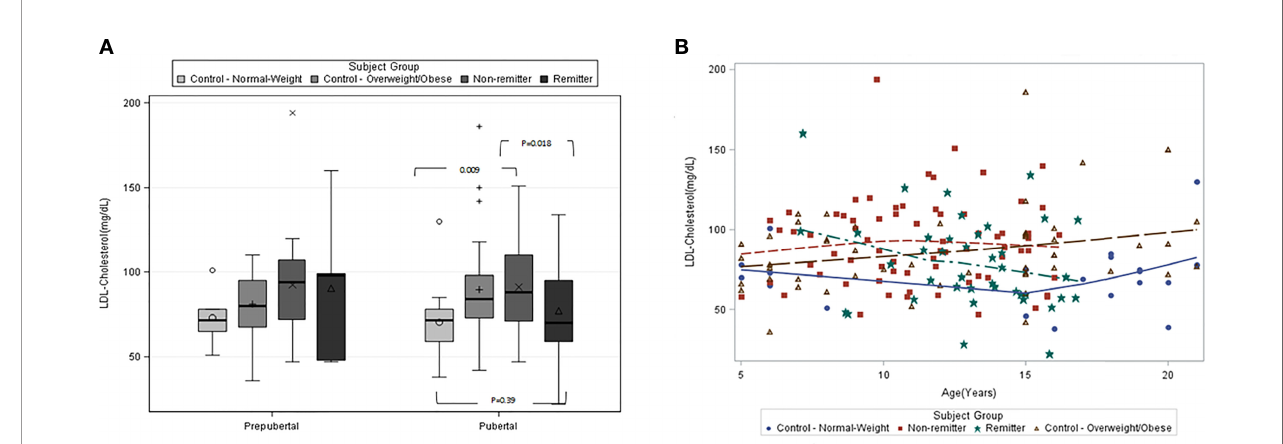
FIGURE 3 | (A) (left panel) and (B) (right panel): (A) is the box plots of low-density lipoprotein cholesterol (LDL-C) concentration strati fi ed by pubertal status in controls and subjects with type 1 diabetes. Among the pubertal cohort, LDL-C was signi fi cantly higher in the non-remitters compared to the remitters (p=0.018), signi fi cantly higher in the non-remitters compared to the normal-weight controls (p=0.009). LDL-C was signi fi cantly higher in the overweight/obese controls compared to the normal-weight control (p=0.033), but similar between the normal-weight controls and remitters (p=0.39) (42). (B) is the scatterplot of the comparison of the patterns of low-density lipoprotein cholesterol (LDL-C) in controls and subjects with type 1 diabetes. Both the remitters and the normal-weight controls demonstrated lower LDL-C during puberty, while the overweight/obese controls and the non-remitters did not